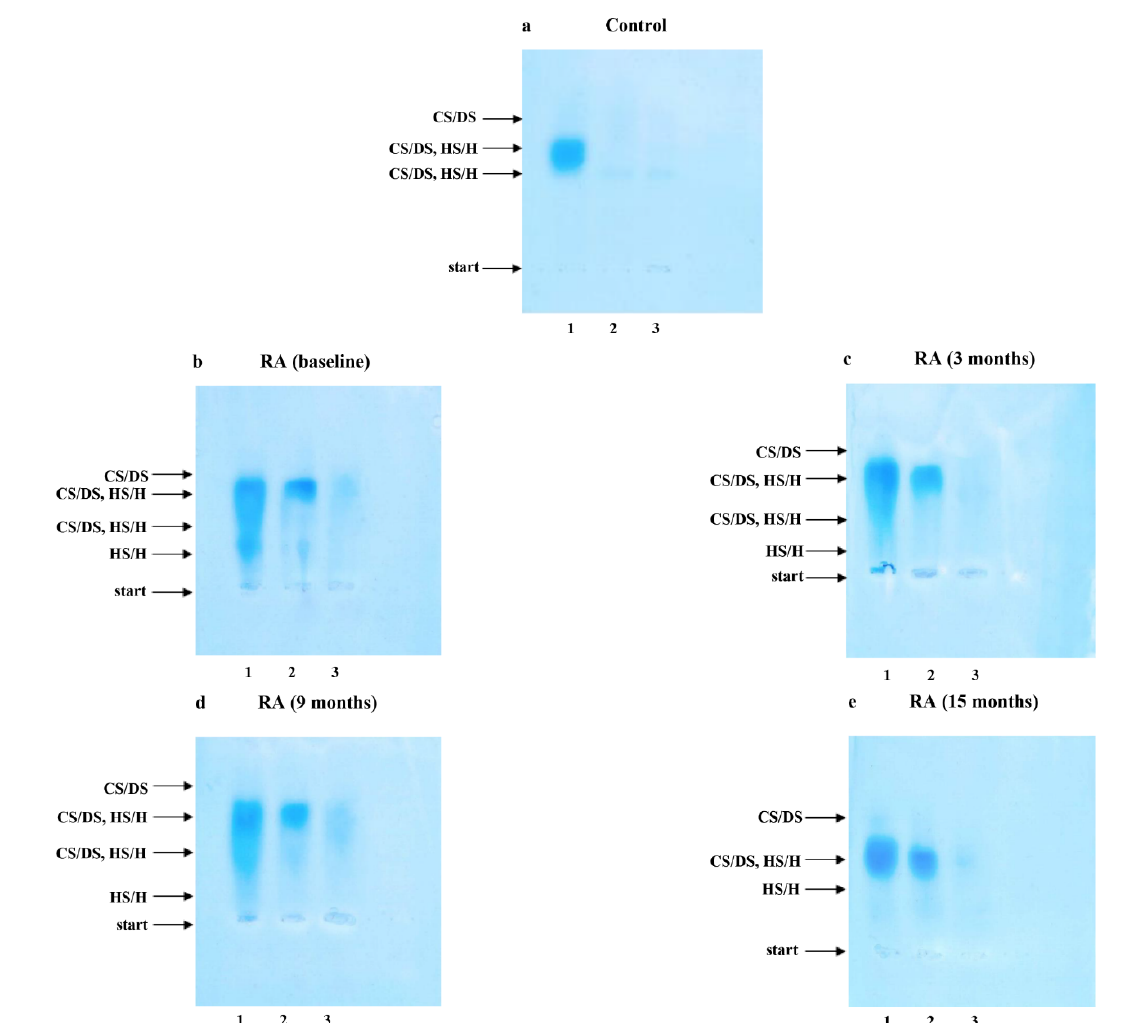
Figure 1. Typical electrophoretic patterns of plasma sulfated glycosaminoglycans (sGAGs) in healthy subjects ( a ) and patients with rheumatoid arthritis (RA) before ( b ) and after 3 ( c ), 9 ( d ) and 15 ( e ) months of anti-TNF- α therapy. GAGs were isolated from plasma samples and submitted to electrophoresis on cellulose acetate in 0.034 M Al 2 (SO 4 ) 3 before and after specific enzymatic degra- dation. Lane 1, untreated GAG sample (CS/DS, HS/H); lane 2, GAG sample resistant to the action of chondroitinase ABC (HS/H); lane 3, material resistant to the combined action of chondroitinase ABC and heparinase I and III. Comparison of electrophoretic patterns of intact material containing CS/DS and HS/H (line 1) with those obtained after chondroitinase ABC digestion (line 2) allowed to localize CS/DS in electrophoregrams (line 1–line 2 = CS/DS). Material resistant to chondroitinase ABC but susceptible to heparinase I and III digestion was identified as HS/H (line 2–line 3 = HS/H). CS/DS, chondroitin/dermatan sulfate; sGAGs, sulfated glycosaminoglycans; HS/H, heparan sulfate/heparin; RA, rheumatoid arthritis; anti-TNF- α , anti-tumor necrosis factor- α